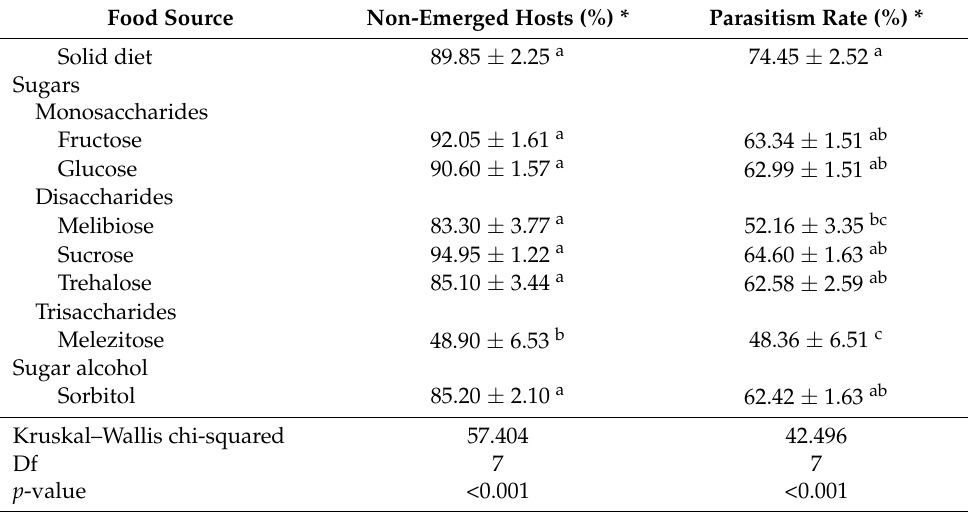
Table 1. Percentage of non-emerged hosts and parasitism rate (mean + SE) in the different treatments with single sugars and solid diet.